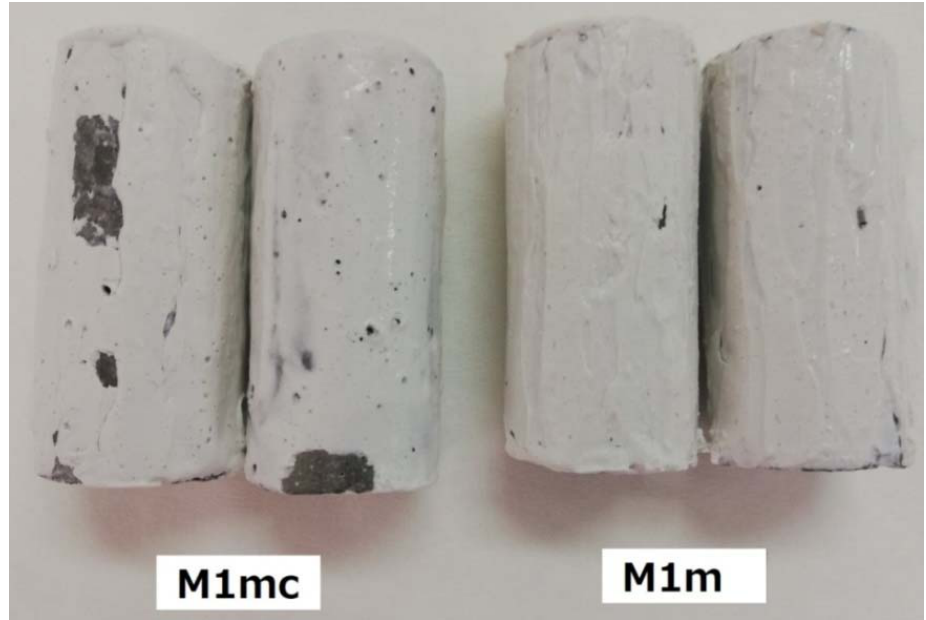
Figure 5. Water resistance of selected coated samples after one ‐ month immersion, and under the influence of slow water circulation (0.05 m/s).